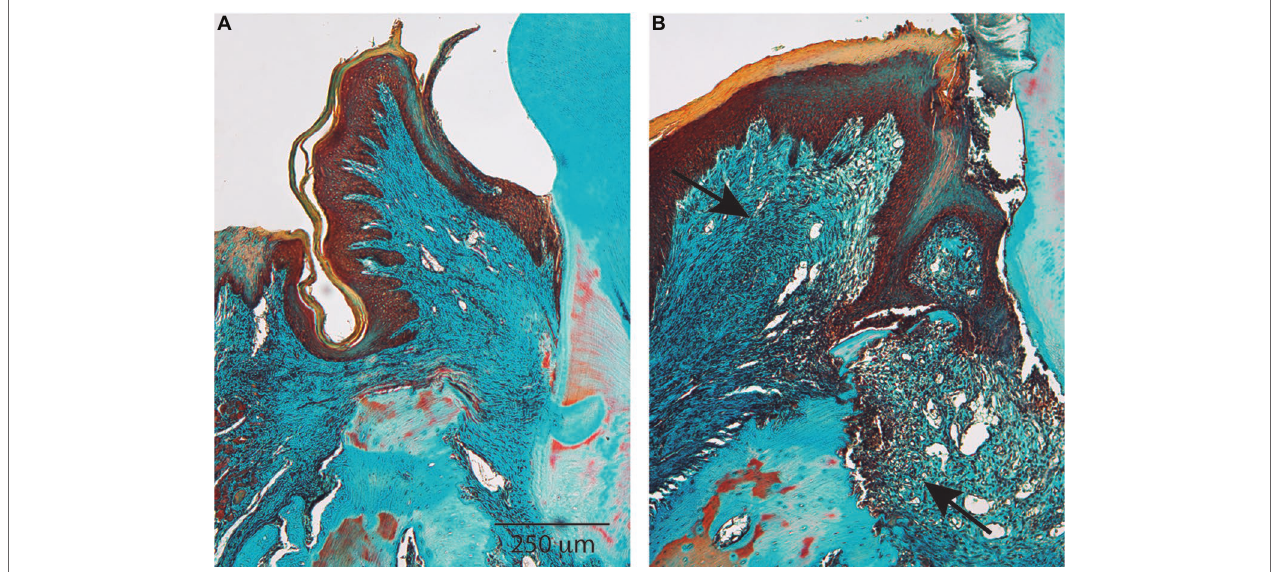
FIGURE 1 | Healthy and diseased periodontium. Histological sections show the most significant characteristics of periodontal tissues in health (A) and disease (B) . Periodontal disease is characterized by chronic nonresolving inflammation in which the wound healing response is not able to regenerate tissues. Arrows indicate the tissue area affected by chronic inflammation. Magnification bar = 250 μ